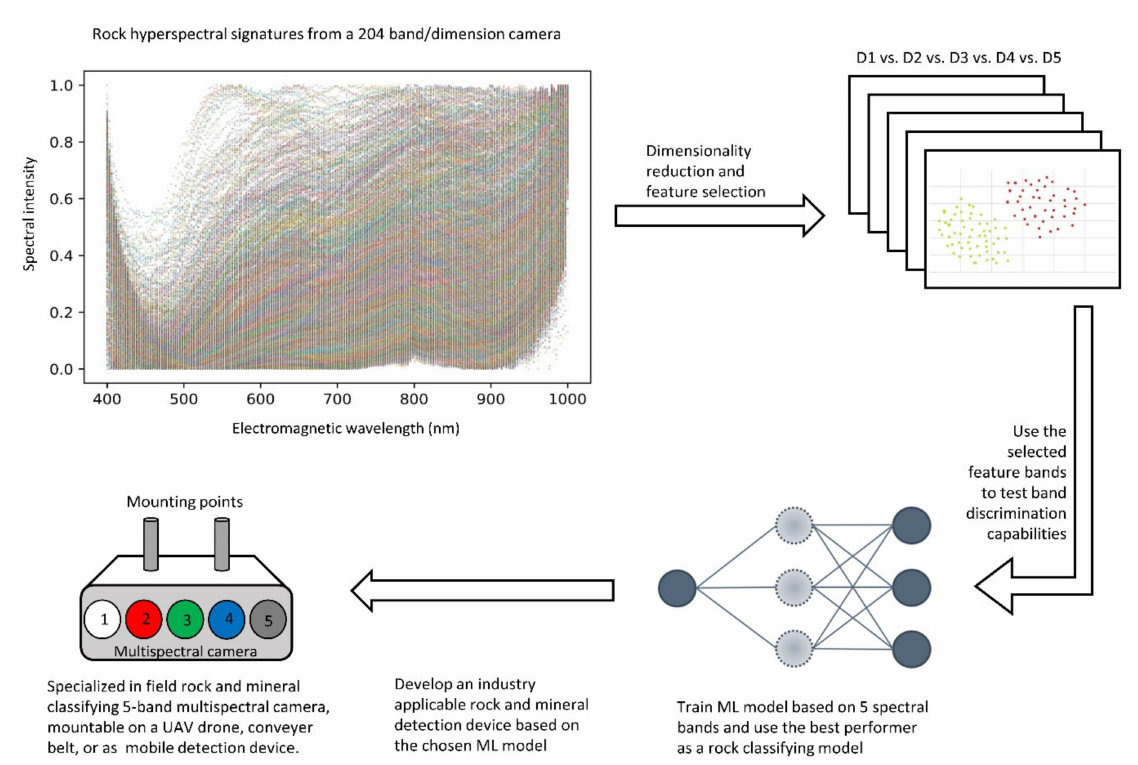
Figure 1. Our proposed system design, consisting of hyperspectral imaging, dimensionality reduction via Neighbourhood Component Analysis, Machine Learning classification of rocks and minerals to test system viability based on the selected features, and finally employing those features together with the ML model in developing a unmanned aerial vehicle drone-mountable multispectral